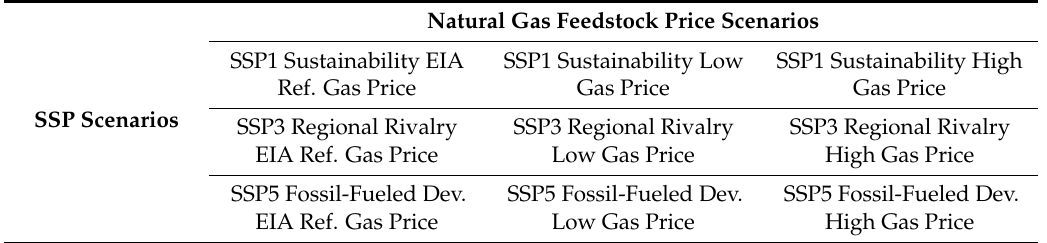
Table 2. Overview of Future Ethylene Supply Scenarios